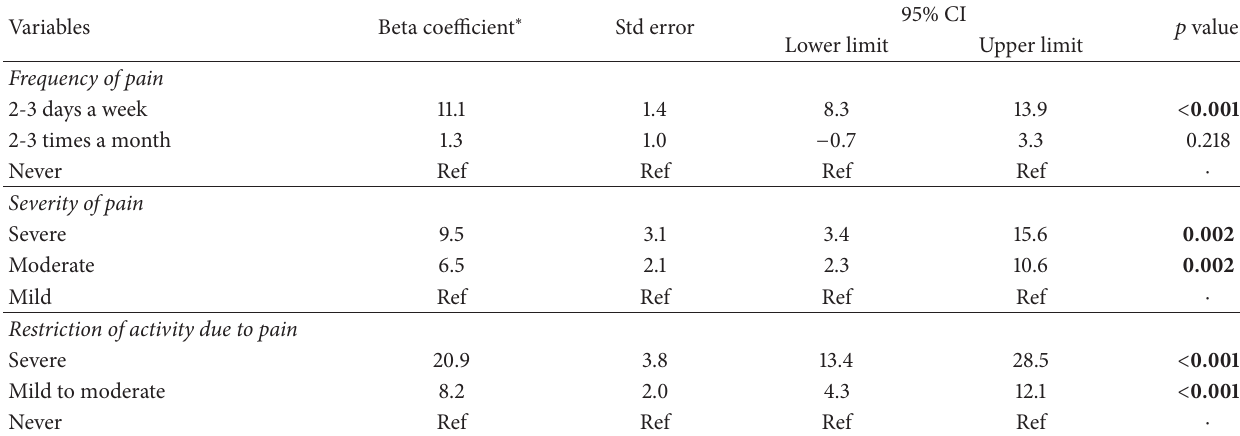
Table 3: Relationship between pain and WHODAS disability